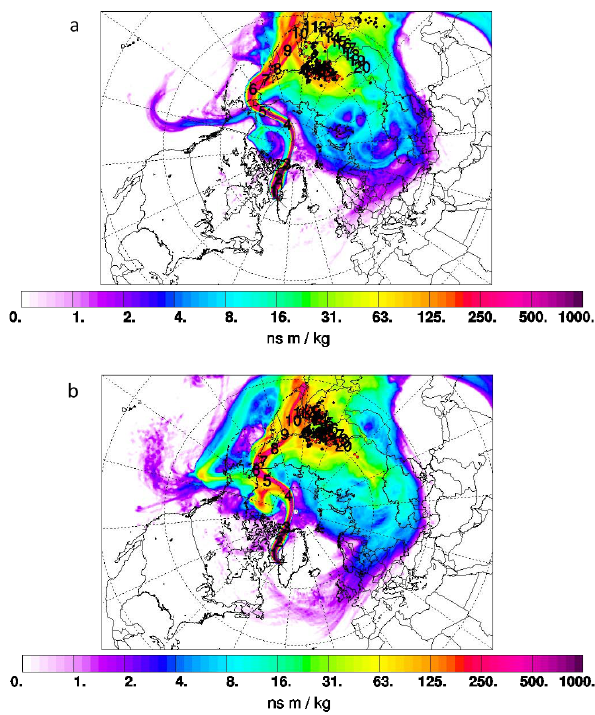
Fig. 6. FLEXPART column-integrated emission sensitivity on 13 July 2008 for ( a) Plume IV, 18:41:32–18:44:54 UTC, and (b) Plume V, 20:02:51–20:03:31 UTC, both showing influences from mixed Asian FF and Siberian BB pollution.